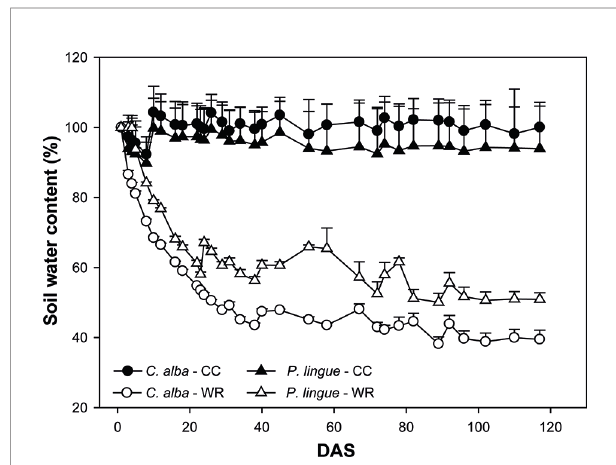
FIGURE 1 | Evolution of soil water content (%) during the water restriction experiment for Cryptocarya alba (circles) and Persea lingue (triangles) plants at container capacity (CC, black symbols) and in the water restriction (WR, white symbols) treatment. DAS, days after onset of stress treatment. Symbols represent mean +